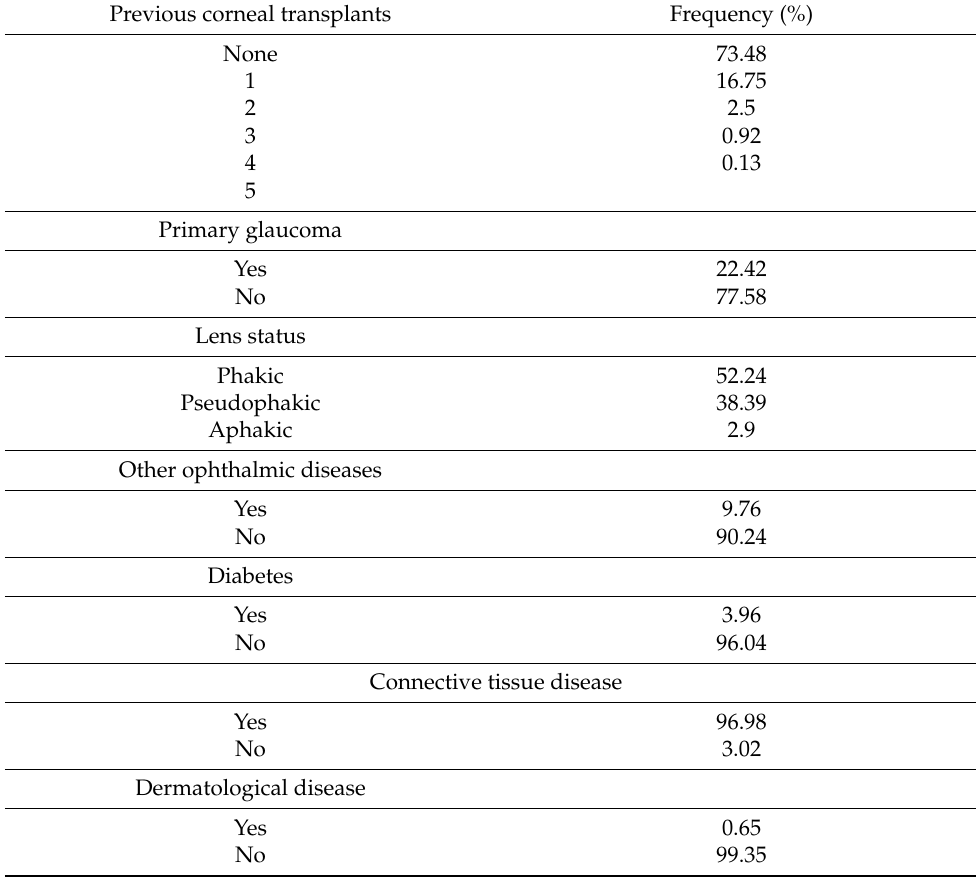
Table 2. Patient